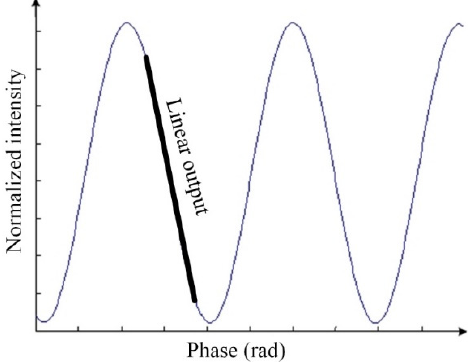
Figure 4. Working area of the interference-intensity demodulation.